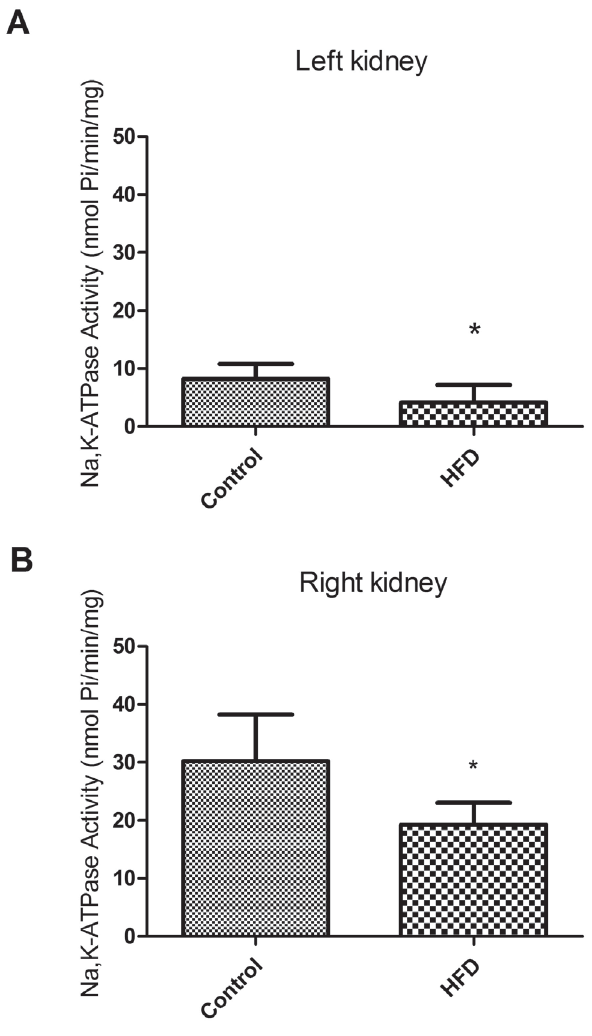
FIGURE 4 - Kidney Na,K-ATPase activity of mice fed with high fat diet. Membrane preparations of left (A) and right (B) kidney were used to determine Na,K-ATPase activity. The experiments were performed in triplicate. * represent p<0.05 of t test